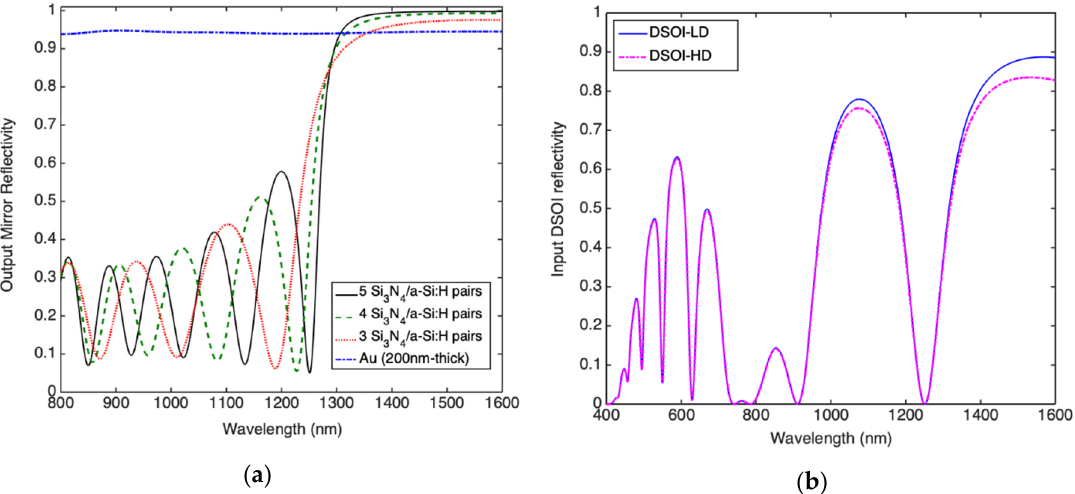
Figure 5. Reflectivity vs wavelength of the: ( a ) output mirror realized by 200 nm-thick Au metal reflector (MR) and distributed Bragg reflector (DBR) constituted by 3, 4 and 5 Si 3 N 4 / a-Si:H pairs and ( b ) input double silicon on insulator (DSOI) mirror constituted by the first c-Si layer both lightly and heavily doped.